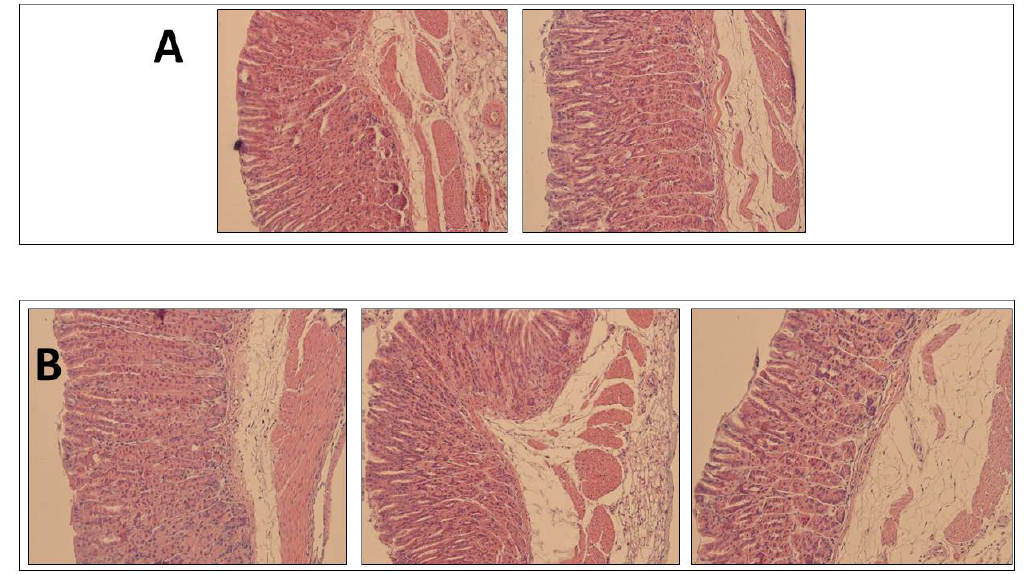
Figure 5. Histological examination of health gastric mucosa after PBS ( A ) of Mucolast ® ( B )